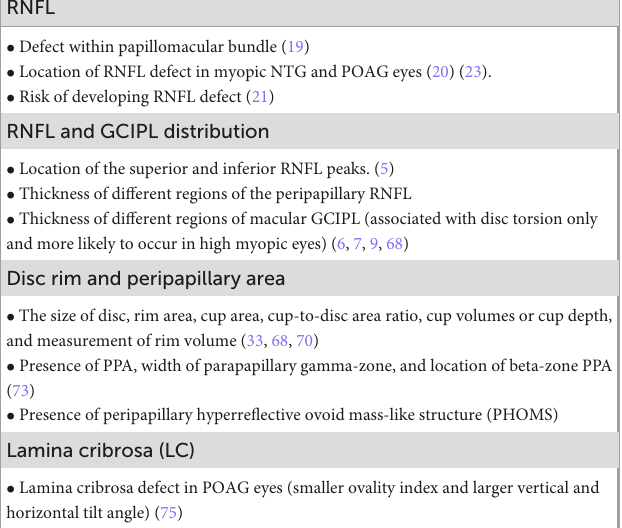
and more likely to occur in high myopic eyes) (6, 7, 9,